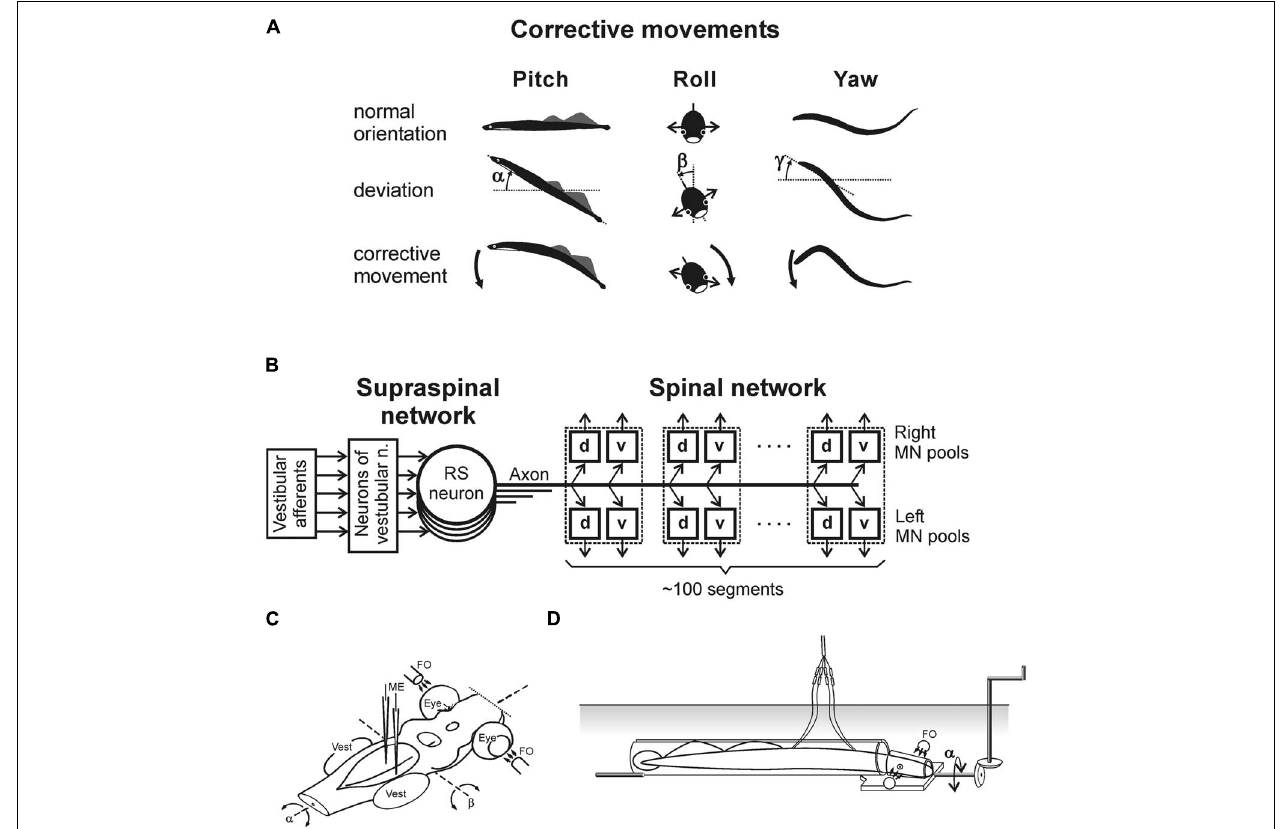
FIGURE 1 | Experiments on the lamprey. (A) During regular swimming, the lamprey stabilizes its orientation in the sagittal (pitch) plane, in the transverse (roll) plane, and in the horizontal (yaw) plane. Deviations from the stabilized orientation in these planes (angles α , β , and γ , respectively) evoke corrective motor responses (large arrows) aimed at restoration of the initial orientation. (B) Commands for correcting the orientation are formed on the basis of vestibular information, processed by neurons of vestibular nuclei, and transmitted from the brainstem to the spinal cord by axons of reticulospinal (RS) neurons. Motor output of each segment is generated by four motoneuron (MN) pools controlling the dorsal and ventral parts of a myotome on the two sides ( d and v